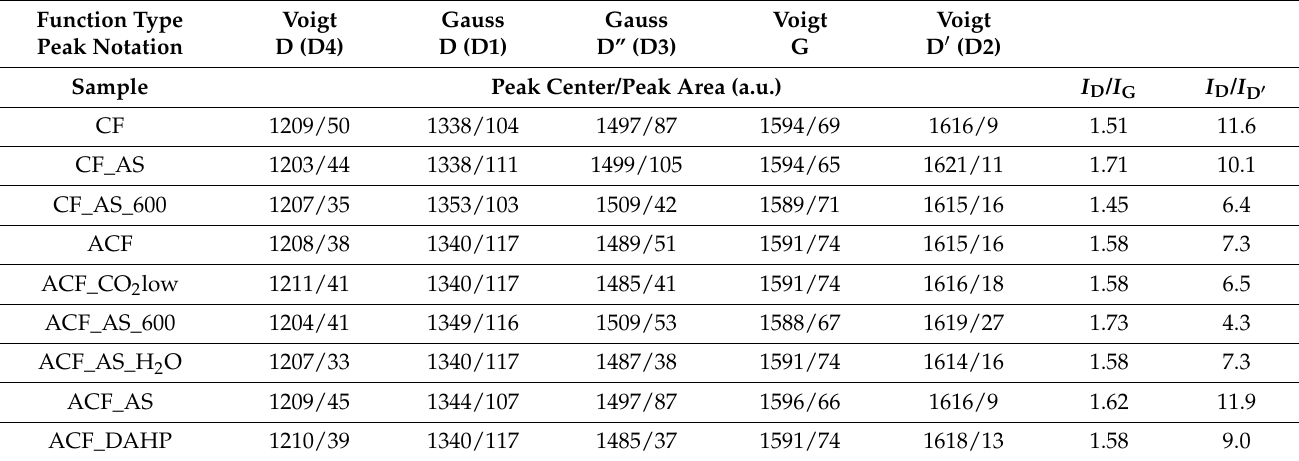
Table 4. The results for the de-convolution of the Raman spectra of investigated samples.